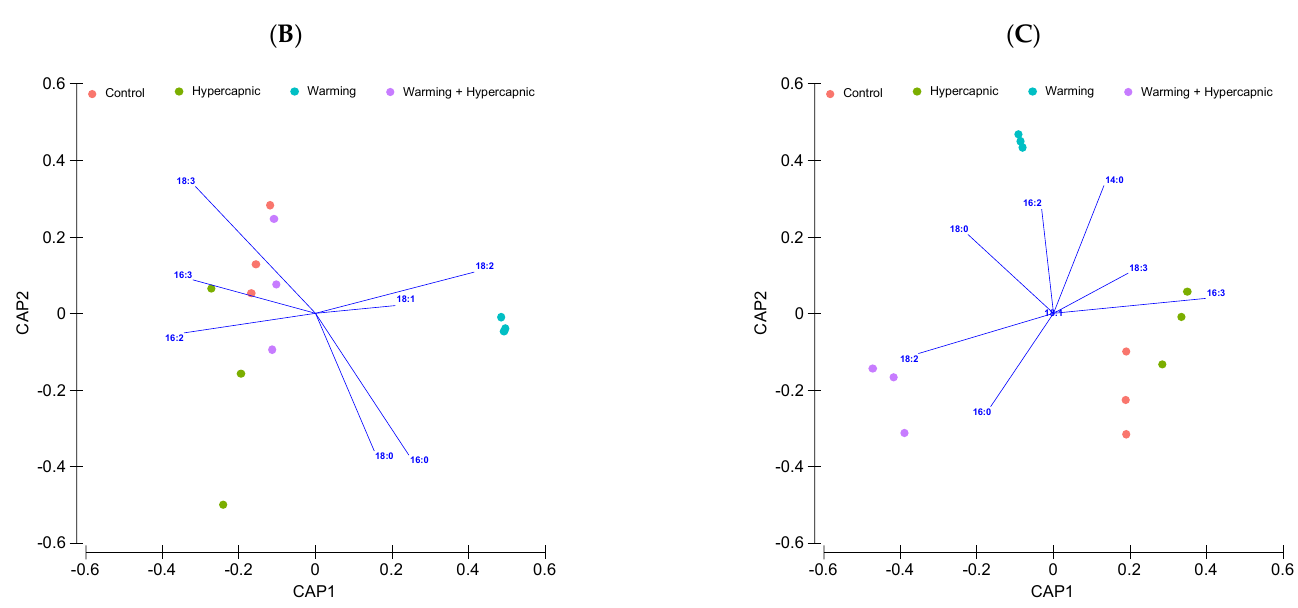
Figure 6. Zostera noltii leaf galactolipid ( A ), monogalactosyldiacylglycerol (MGDG) ( B ), and digalactosyldiacylglycerol (DGDG) ( C ) fatty acid relative concentration canonical analysis of principal (CAP) components of the samples exposed to control, hypercapnic, warming and combined stress conditions ( n = 3 per